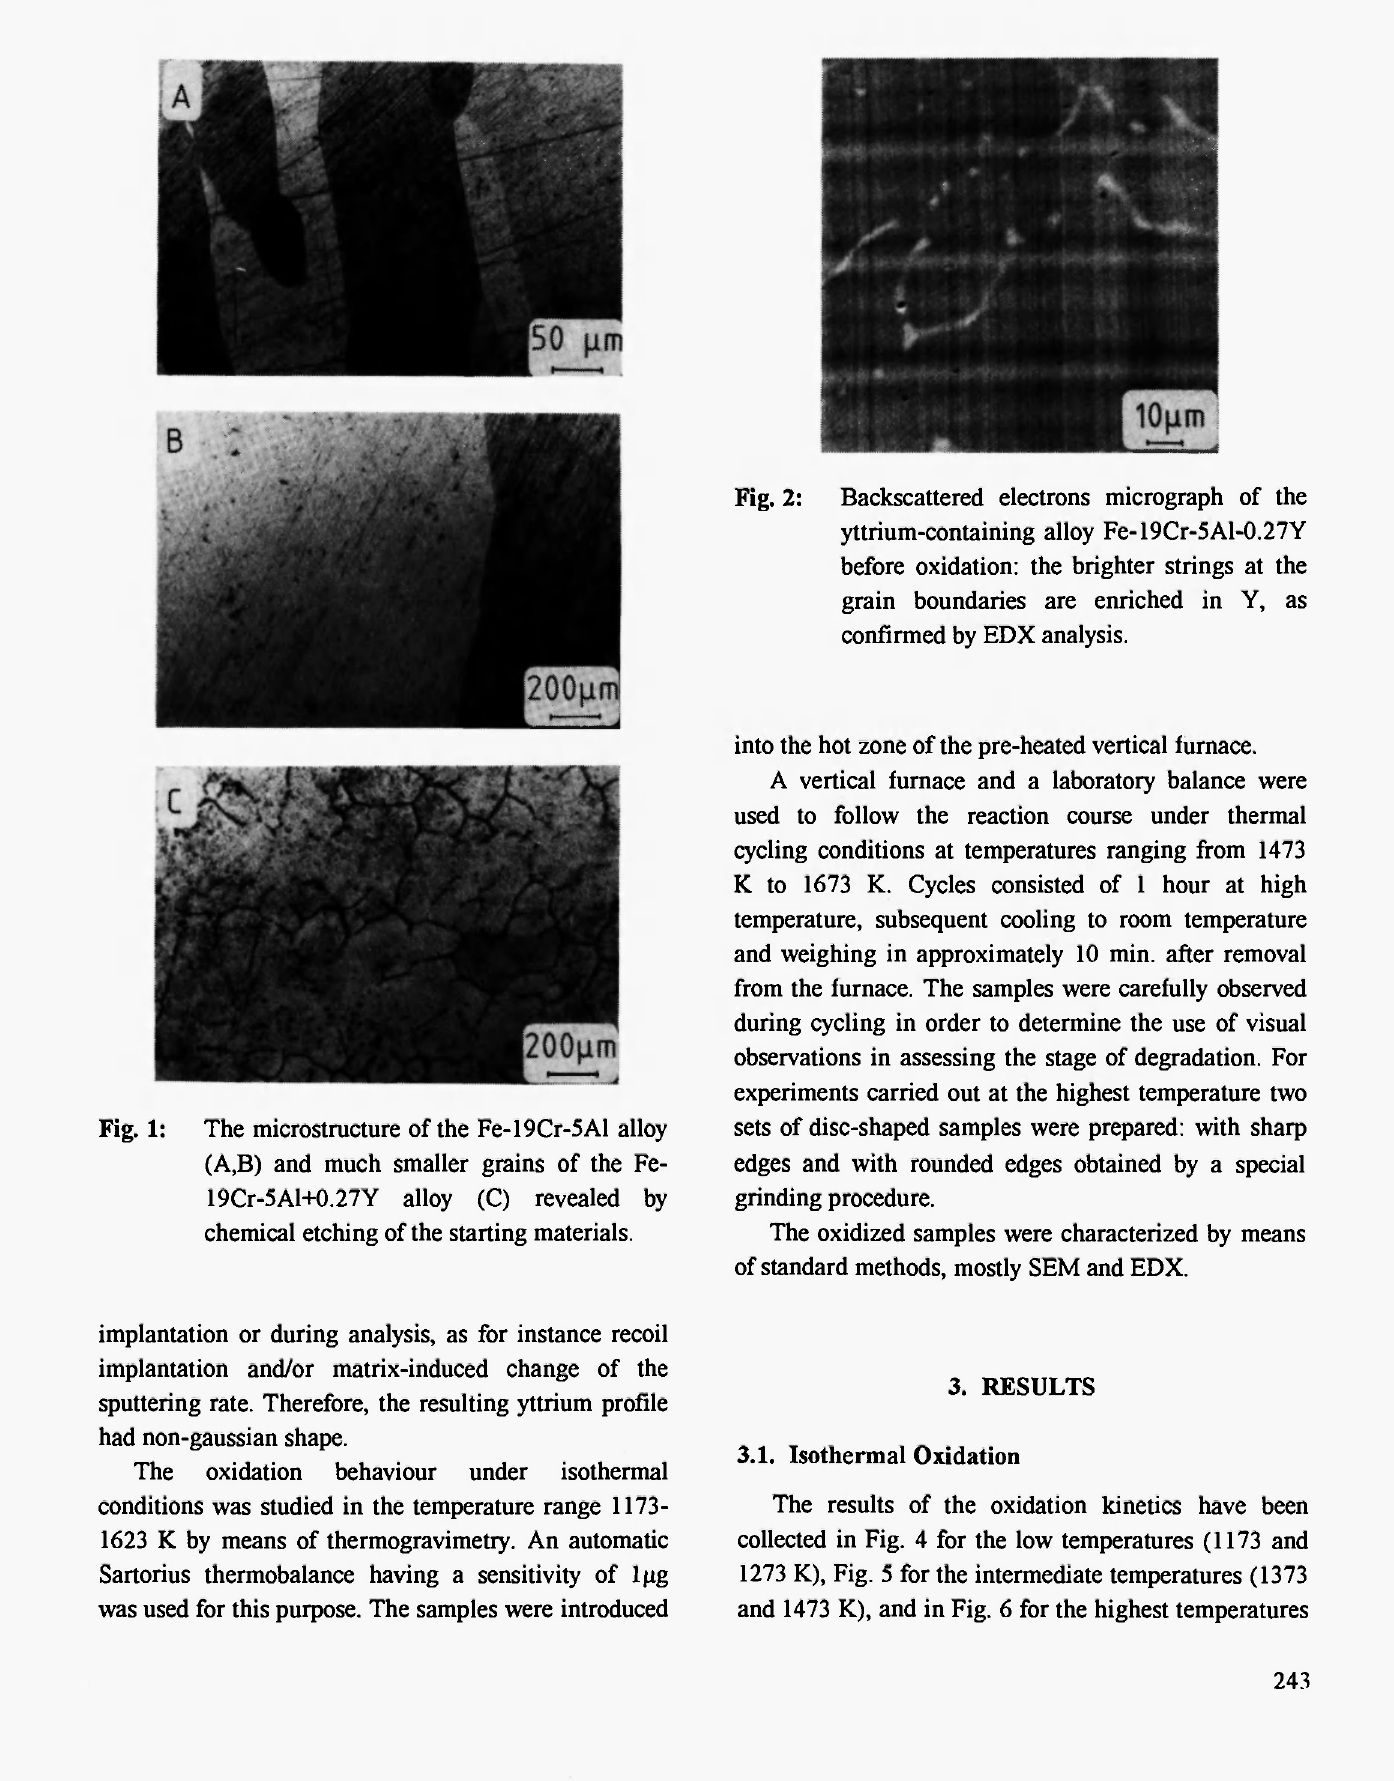
Fig. 2: Backscattered electrons micrograph of the yttrium-containing alloy Fe-19Cr-5Al-0.27Y before oxidation: the brighter strings at the grain boundaries are enriched in Y, as confirmed by EDX